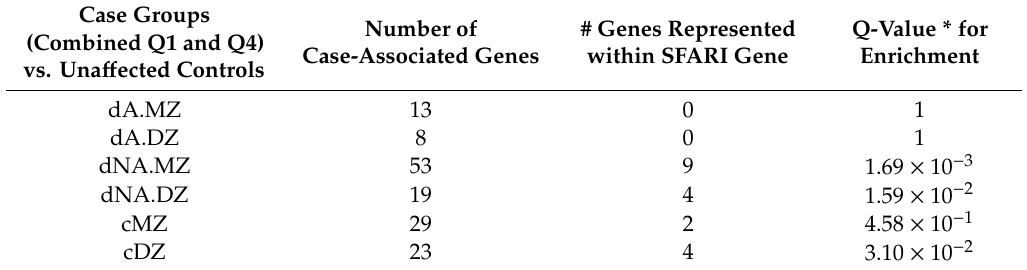
Table 3. Hypergeometric analyses of case-control associated genes and SFARI genes.